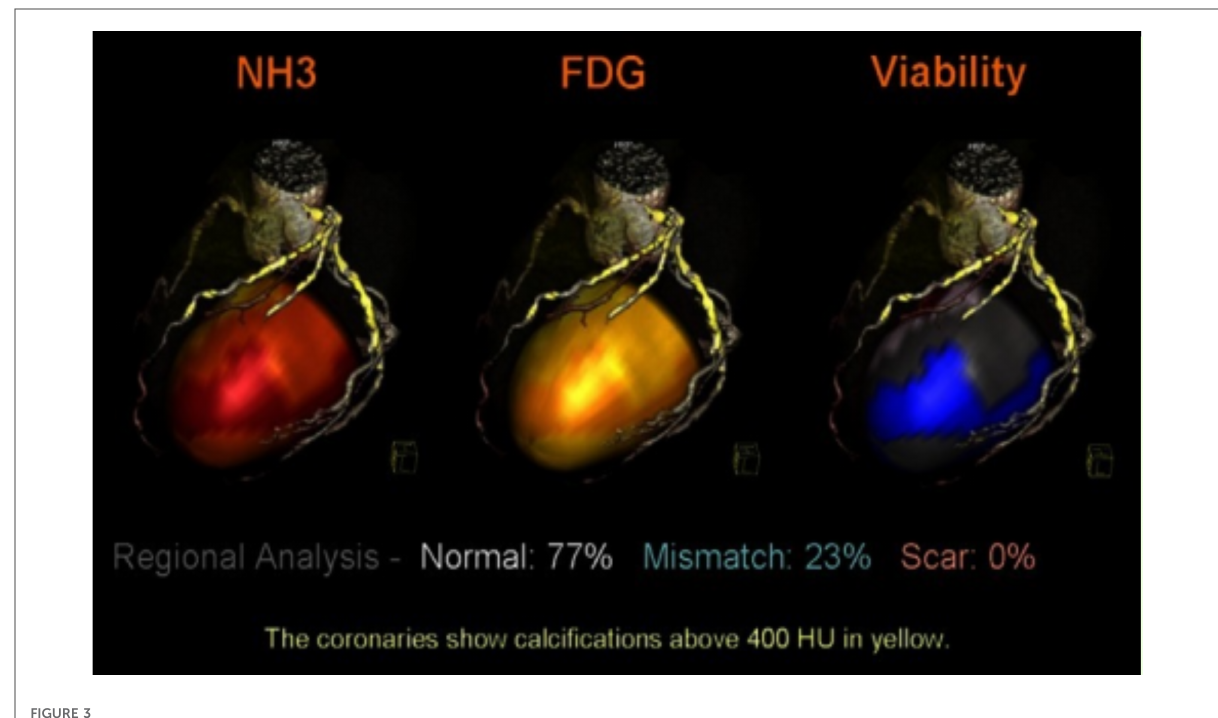
FIGURE 3 PET perfusion data mapped onto the epicardial surface of CT angiography to evaluate the viability of cardiac muscle and segmented coronary tree. The image depicts the simultaneous mapping of metabolism, coronary anatomy, and myocardial perfusion via fused images. NH3, ammonia, FDG, F- fl uorodeoxyglucose, HU, Hounse fi eld units (23).